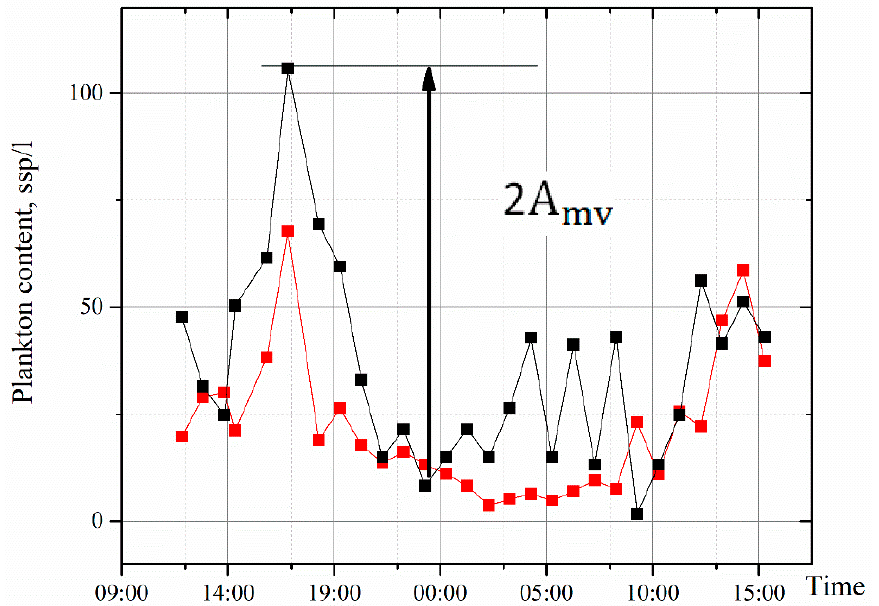
Figure 8. Plankton content in 1 L near the mooring station. Red line—result after processing the samples obtained by a net. Black line—time series of holographic measurements of plankton number over the same period of time.